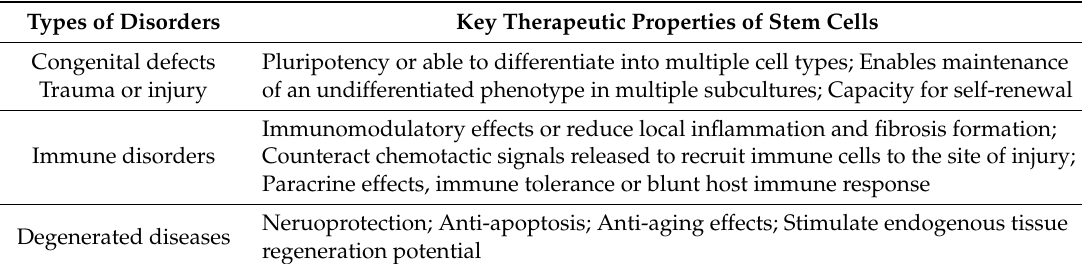
Table 1. Overview of key therapeutic properties of mesenchymal stem cells in different disorders. Types of Disorders Key Therapeutic Properties of Stem